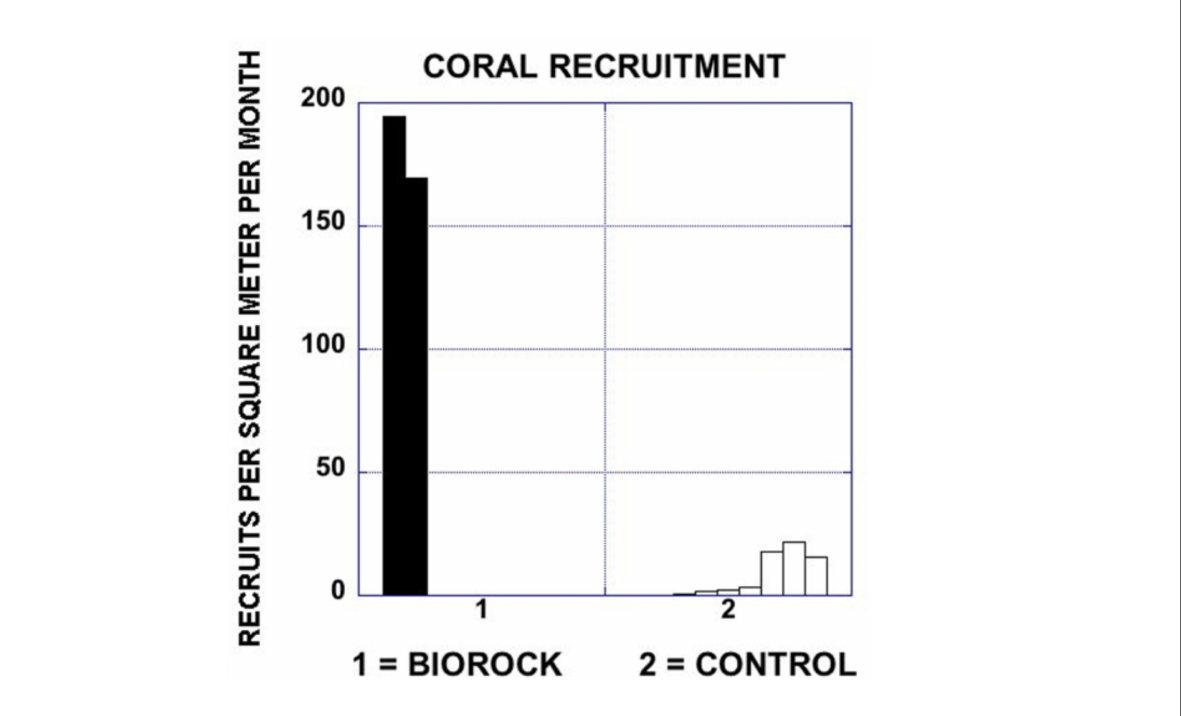
FIGURE 5 | Coral recruitment, from Goreau,